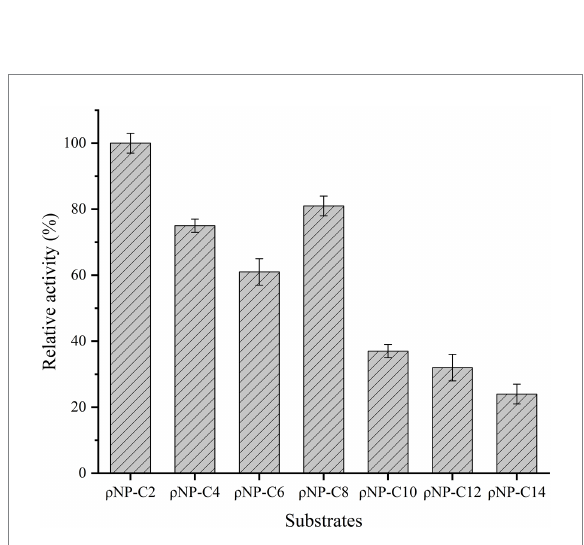
FIGURE 4 Substrate specificity of Est882. The data point is the average of the three measurements, and the error bar represents the standard